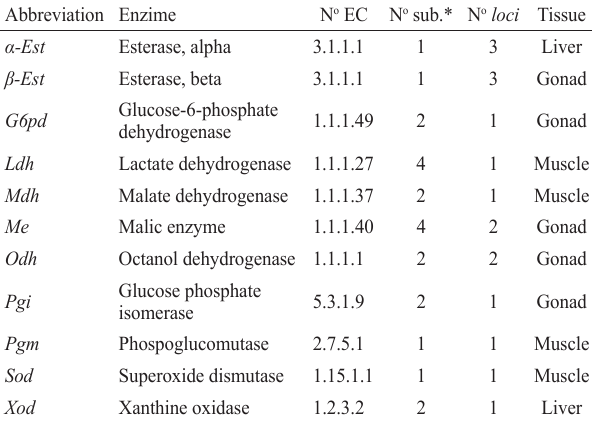
Tab. 1. Enzymatic systems sampled in this work, with their abbreviations, commission number (N o EC), number of subunits (N o sub; *1 = monomeric; 2 = dimeric; 4 = tetrameric), number of interpreted loci , (N o loci ) and tissue used for each